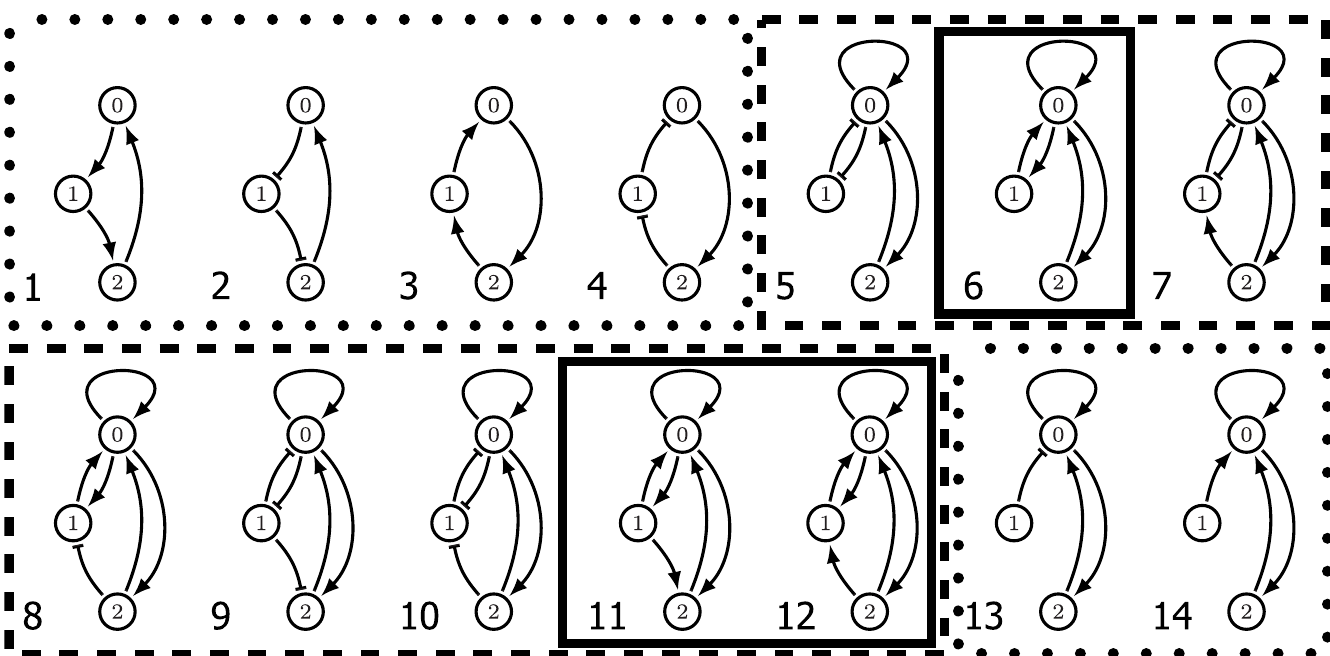
Fig 3. The top fourteen regulatory networks by hysteresis score. The six regulatory networks in dotted boxes are fragile, while the eight outlined via the dashed lines are robust. Observe that the three networks outlined by the solid lines are also consistent and each node acts only as an activator.